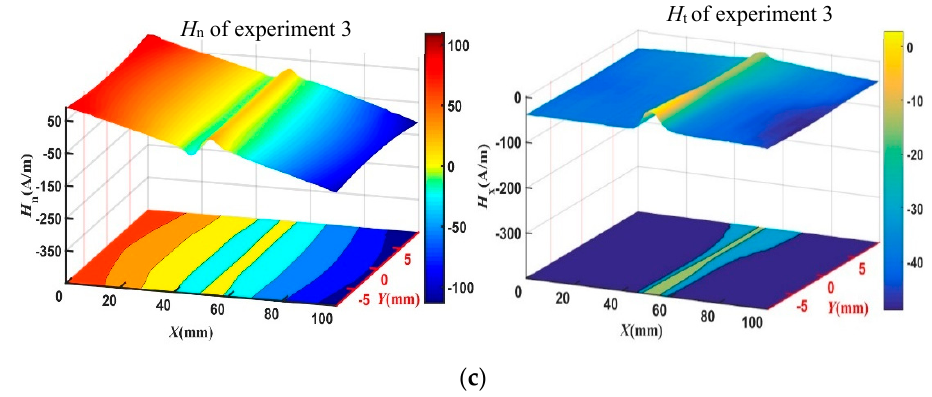
Figure 8. Surface and contour maps of the normal and tangential components of MFL signals. ( a ) Loading to 25 kN in experiment 1 (static tension); ( b ) 8 h of corrosion in experiment 2 (corrosion without loading); ( c ) 8 h of corrosion in experiment 3 (corrosion after loading).